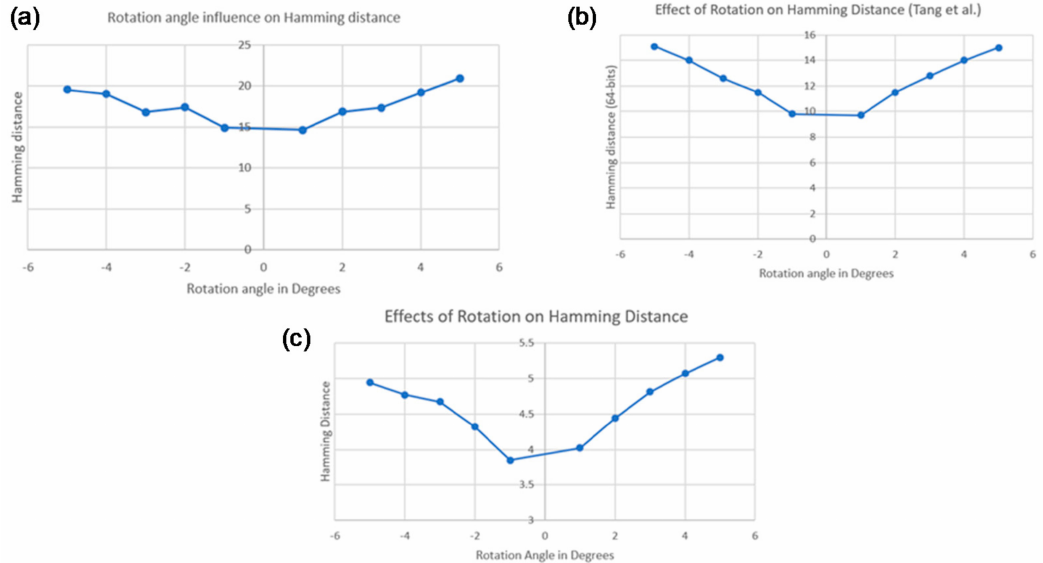
Figure 7. Effect of rotation on hamming distance: ( a ) for a ‘non-cork’ database; ( b ) for a similar ‘non-cork’ database [21]; ( c ) for a cork